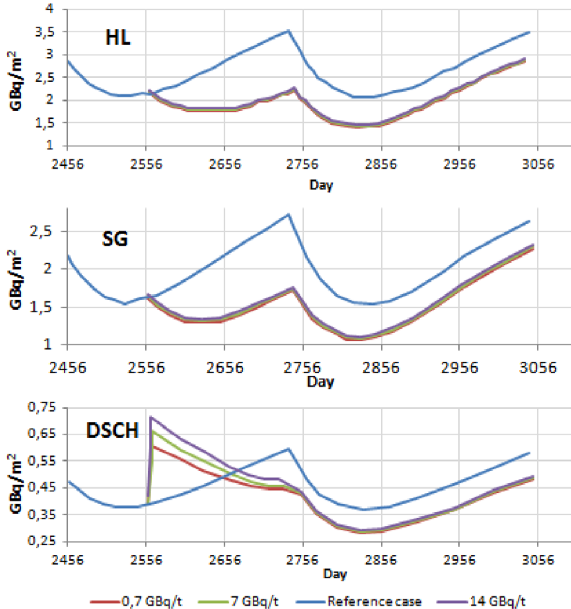
Fig. 5. 58 Co activities deposited on the hot legs (HL), the steam generators (SG) and the letdown lines (DSCH) in the case of a mid-cycle shutdown 6 months before the end of cycle.